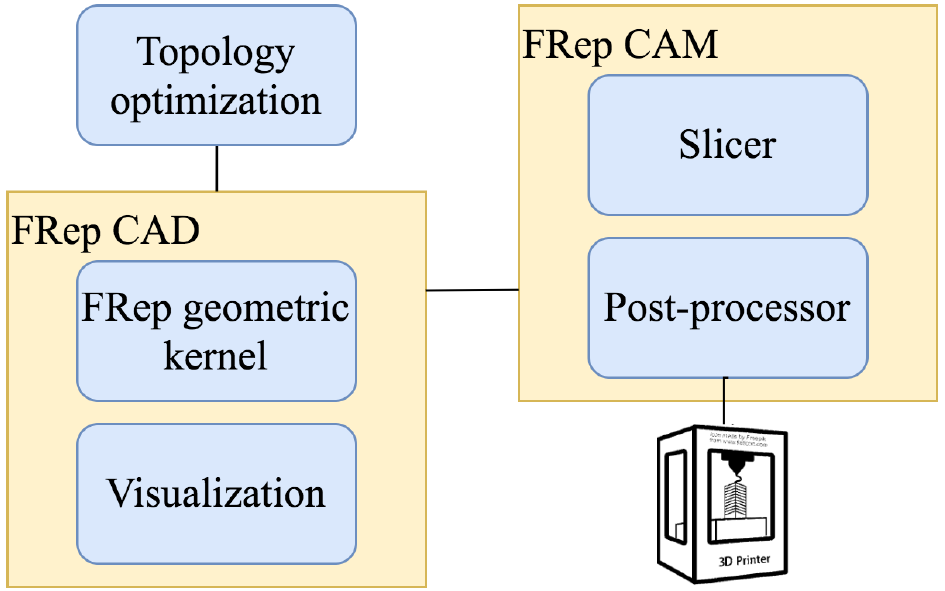
Figure 1. The principal components of the FRep